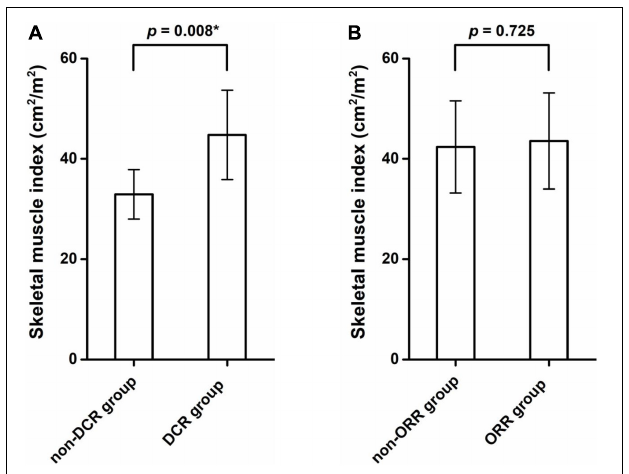
FIGURE 4 | The mean skeletal muscle index (SMI) of the disease control rate (DCR) group was significantly higher than that of the non-DCR group (44.77 ± 9.06 vs. 32.94 ± 5.49 cm 2 /m 2 , p = 0.008) (A) . No significant difference in SMI values was found between ORR group and non-ORR group (42.37 ± 9.49 vs. 43.56 ± 9.84 cm 2 /m 2 , p = 0.725) (B) . *Indicates significant